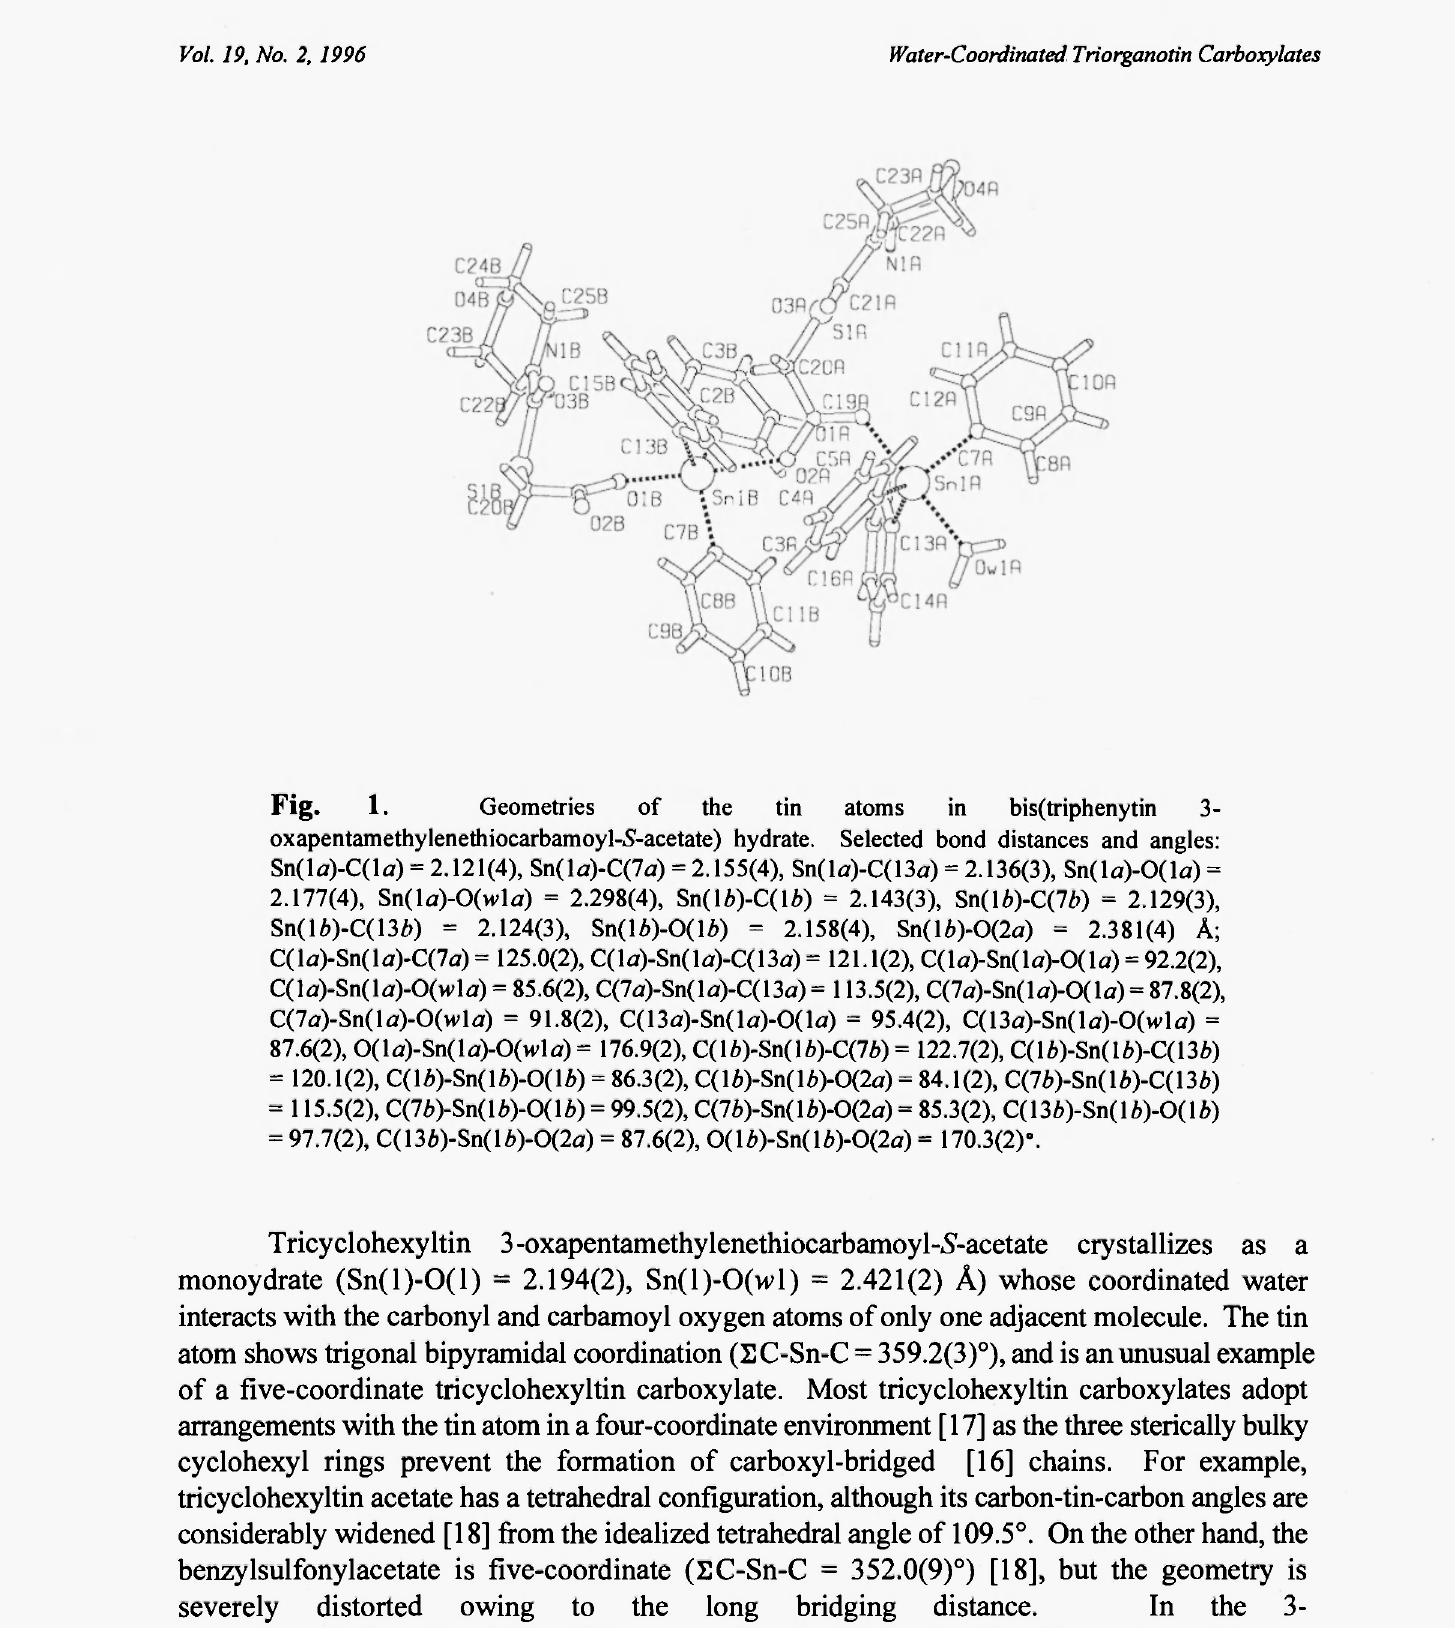
Fig. 1. Geometries of the tin atoms in bis(triphenytin 3- oxapentamethylenethiocarbamoyl-S-acetate) hydrate. Selected bond distances and